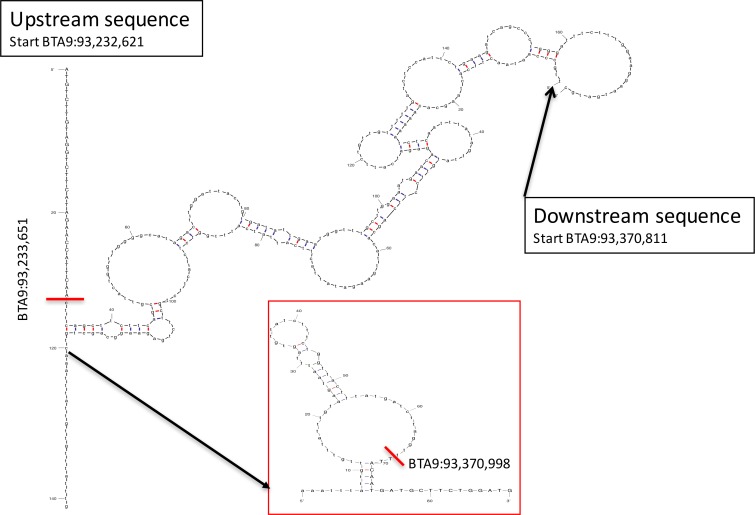
Schematic drawing of the most likely homologous hybridization between the two repetitive elements within the deleted sequence.A stable dsDNA structure is formed with a free Gibbs energy (∆G37°) of -13.5 kcal/mol and further downstream a stable secondary structure within the single strand is formed (∆G37° = -4.3 kcal/mol), shown as insert. The fusion points are marked with red lines, based retained after fusion of the sequences are shown as capital letters, small letters depict the sequence parts that are deleted. Calculations and drawings are created using UNAfold (http://unafold.rna.albany.edu) [46].